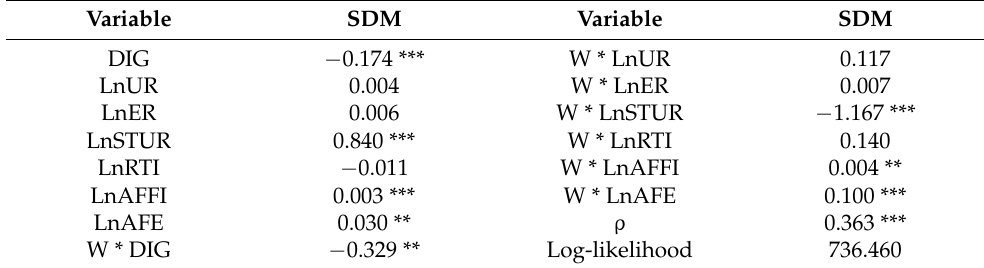
Table 8. Spatial Durbin Model estimation and test results.